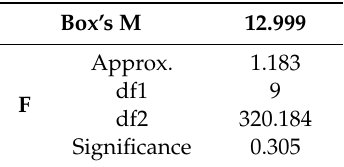
Table 13. Box’s M